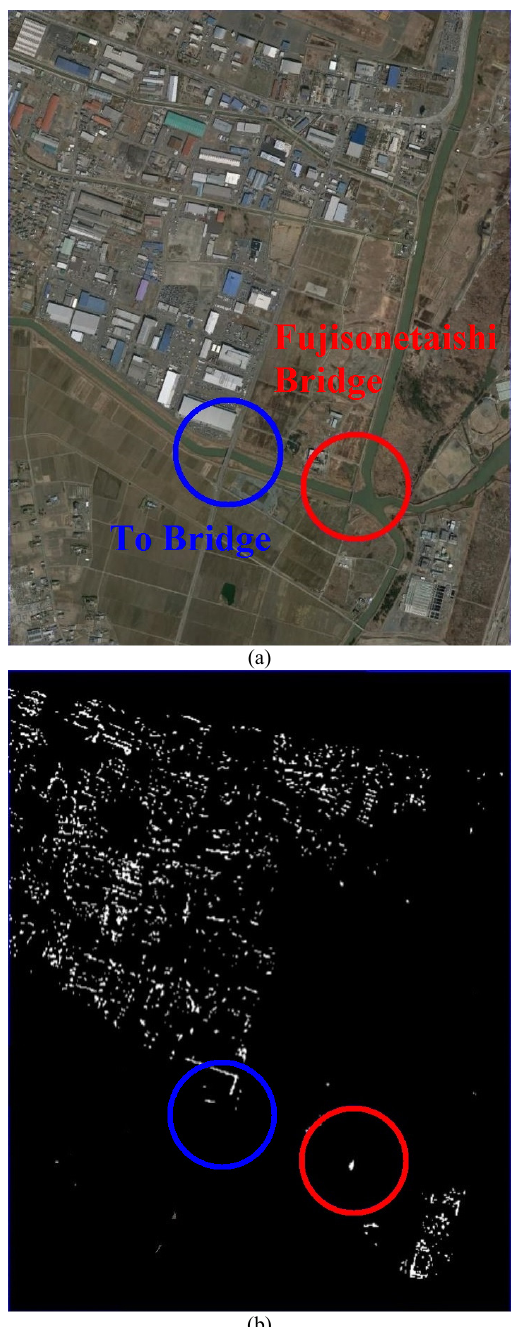
(b) Figure 8. (a) Google Earth image imposed within the study area for detecting damaged bridge using Curvelet-based approach (section 4.4). To and Fujisonetaishi Bridges are encircled by blue and red circles, respectively. An industrial area (Sendai Kuko Iwanuma Rinku Kogyo Danchi) is situated in the top-left part surrounded by farmlands and waterways. The location of this study area is indicated by a blue square in Figure 1. (b) The extracted linear-feature changes (white) by Curvelet-based approach in the study area (a).